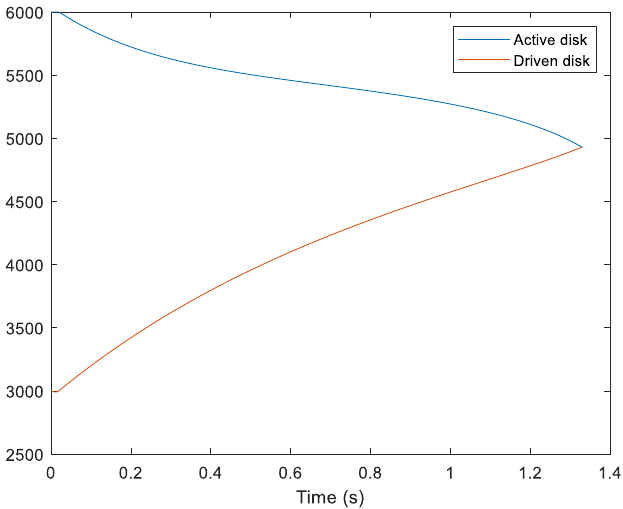
Figure 7. The relationship between rotation speed and time during paper-based friction disk engagement. Table 2. Actual contact area of the friction disks with different grooves.